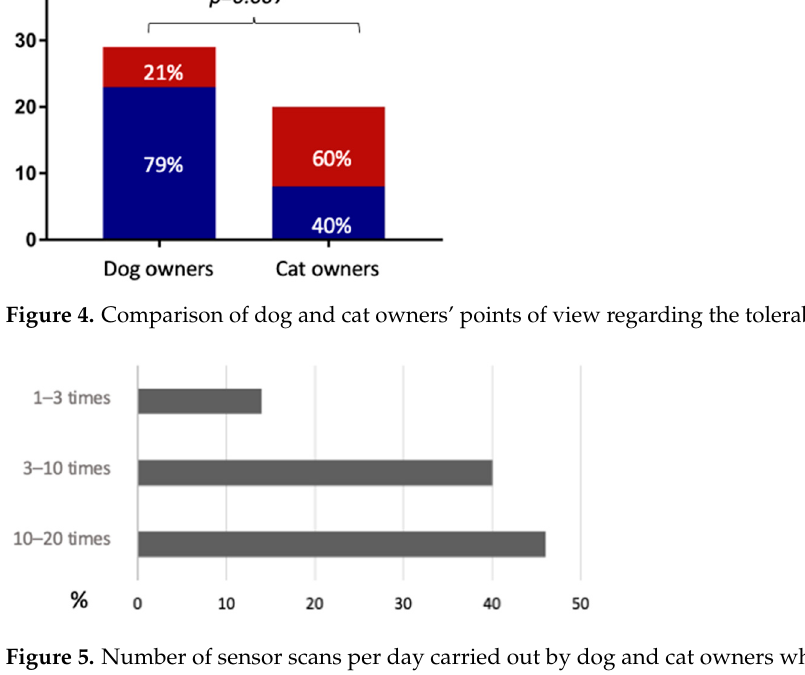
Figure 4. Comparison of dog and cat owners’ points of view regarding the tolerability of the sen ‐ sor.